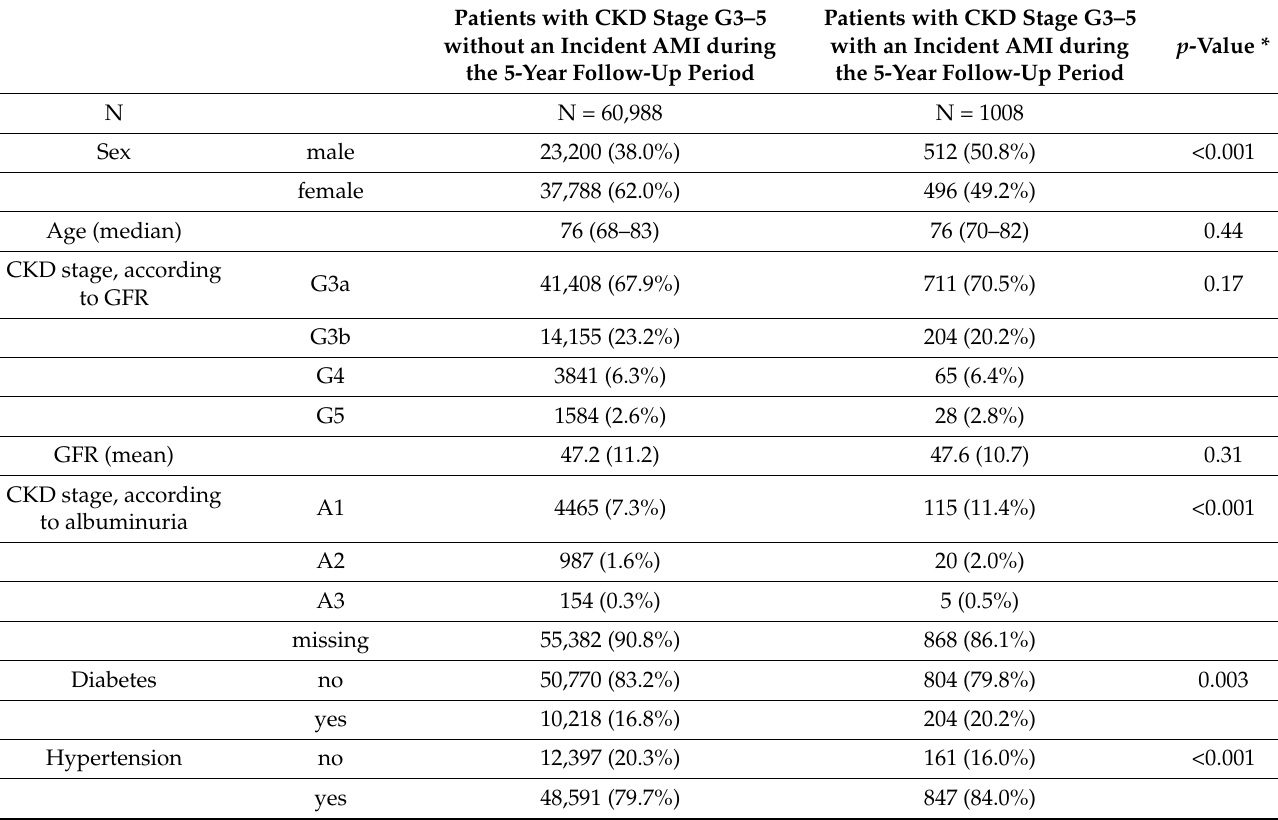
Figure 2. Trends of incident AMI in patients with CKD stage G3–5 during the 5-year follow-up period. Table 1. Characteristics of CKD G3–5 patients without AMI prior to CKD debut with and without incident AMI during 5-year